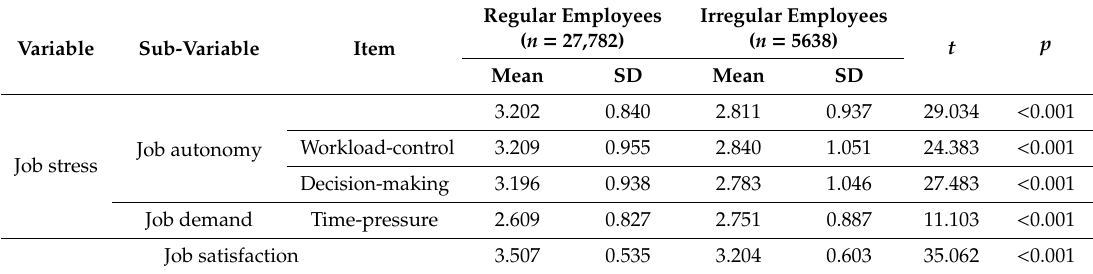
Table 2. Characteristics of job stress and satisfaction in regular and irregular